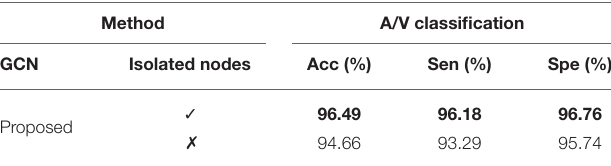
TABLE 2 | Isolated background node contribution using the AV-DRIVE dataset ( 3 = with; 7 =